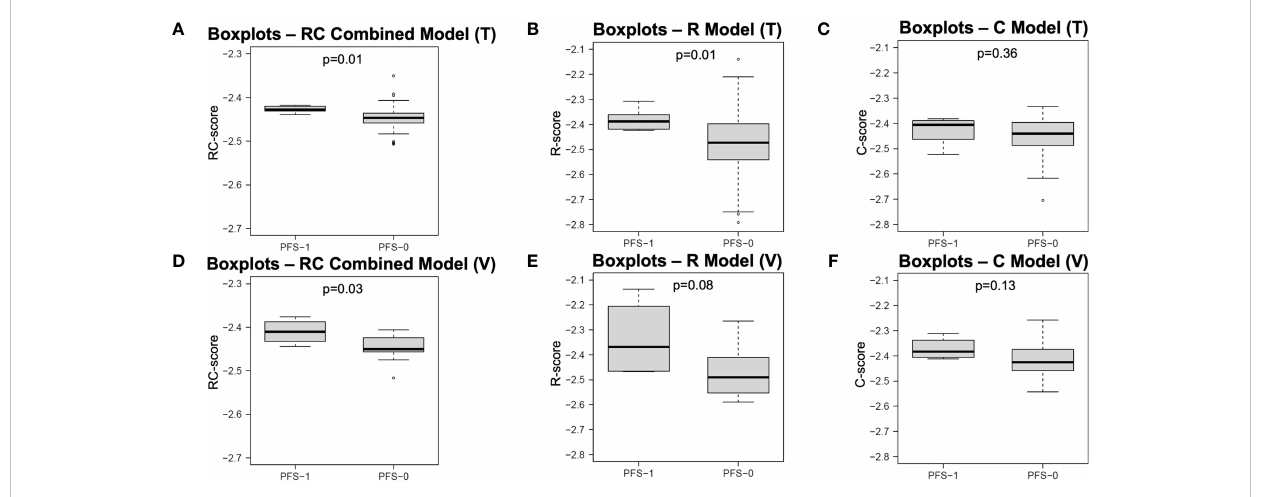
FIGURE 5 Boxplots of model scores of R, C and RC combined models. The boxplots in fi rst (A – C) and second rows (D – F) display the distribution of model scores calculated by different models in training and validation cohorts, respectively. R, Radiomics; C, clinical; RC, Radiomic-clinical; T, training cohort; V, validation cohort; PFS, progression-free